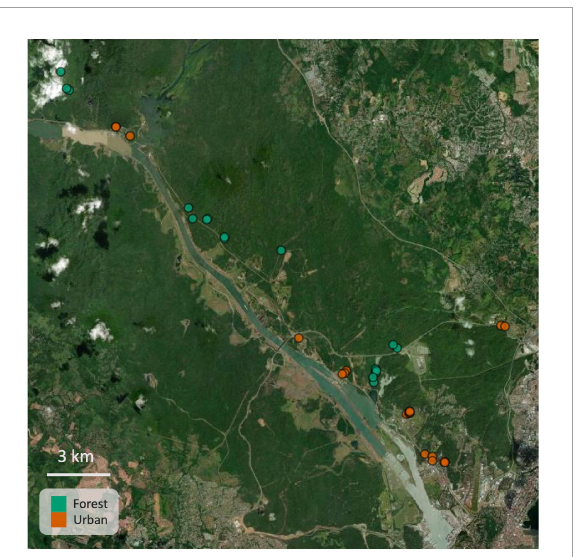
FIGURE1 Map showing urban (orange) and forest (green) sampling locations around Panama City, the canal zone and in national forests (Soberanía and Camino de Cruces). Map was created using the leaflet package in R (Cheng et al.,